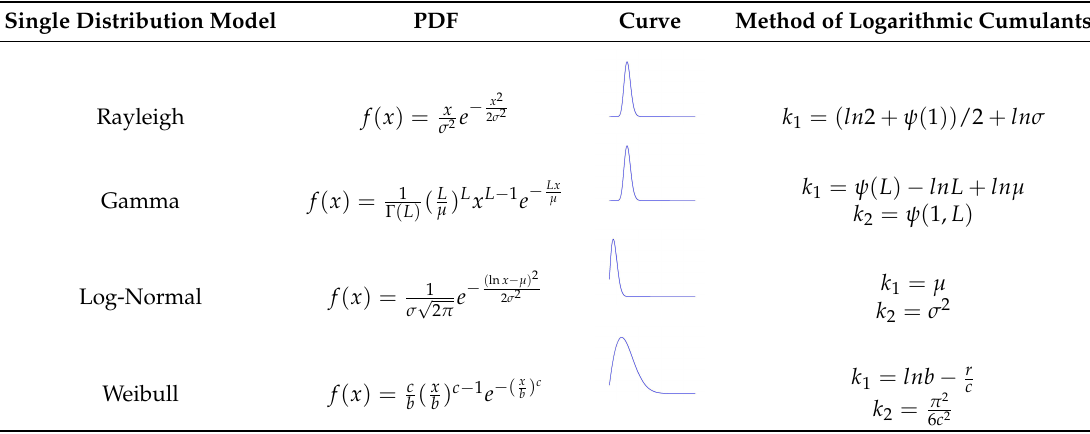
Table 1. Parameter estimation for the statistical distribution